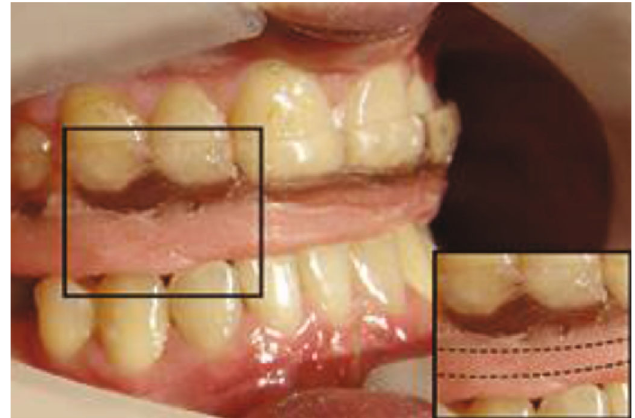
Figure 4: Occlusal repositioning splint used during fi rst phase of prosthodontic treatment. In right corner, picture showing approximate thickness of each layer.